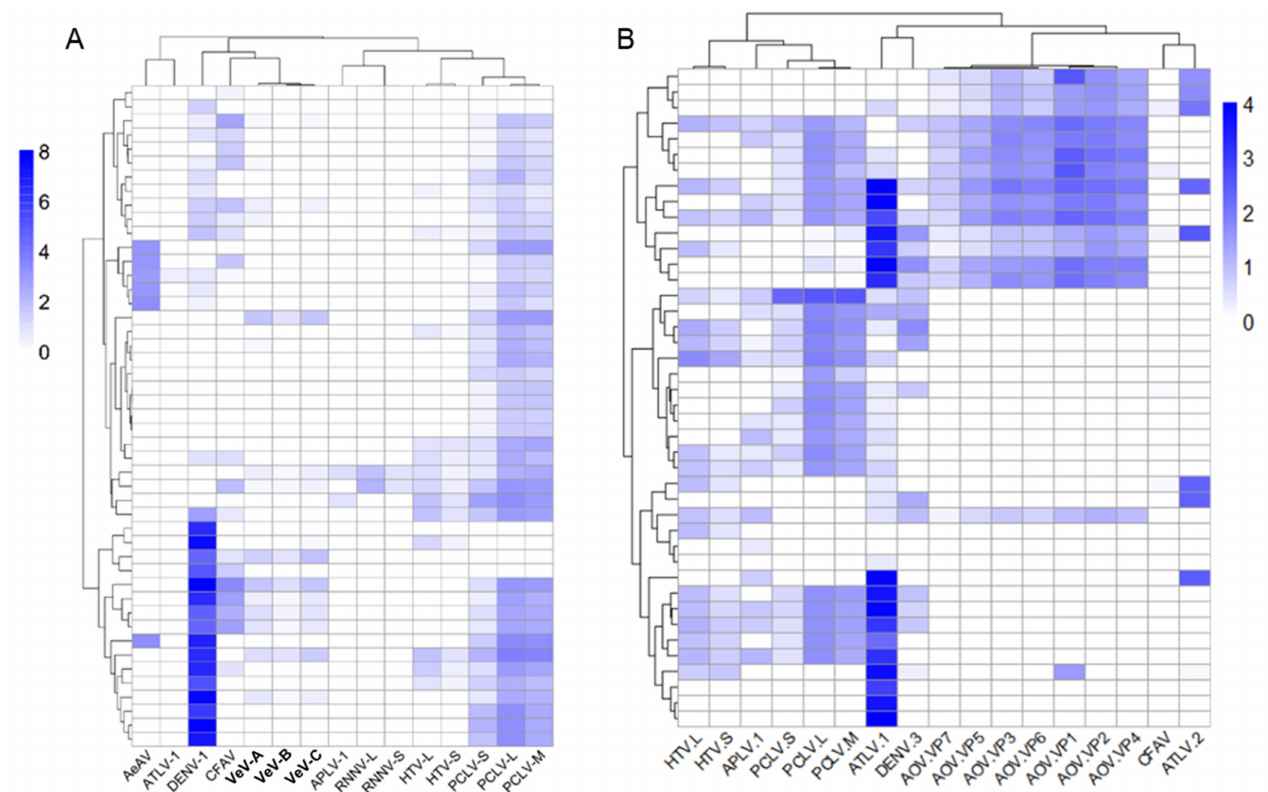
Figure 10. Abundance of viruses from individual Aedes aegypti mosquitoes. mRNA-enriched libraries prepared from midguts from Raquin et al. 2017 [119], ( A ), and whole mosquitoes from Koh et al. 2018 [108]. ( B ) Abundance is represented as log 10 (RPKM) mapped reads per million per kilobase. Hierarchical clustering was performed using Pearson complete distance measurement method. Heat map produced using pheatmap R package. RNNV: Renna virus, HTV: Humaita- Tubiacanga virus, APLV-1: Aedes partiti-like virus 1, VeV: Verdadero virus, DENV-1: dengue virus 1 (KDH0030A), DENV-3: dengue virus 3 (JN406515.1), AeAV: Aedes anphevirus, PCLV: Phasi Charoen-like virus, CFAV: Cell fusing agent virus, ATLV-1: Aedes toti-like virus 1, ATV: Aedes toti